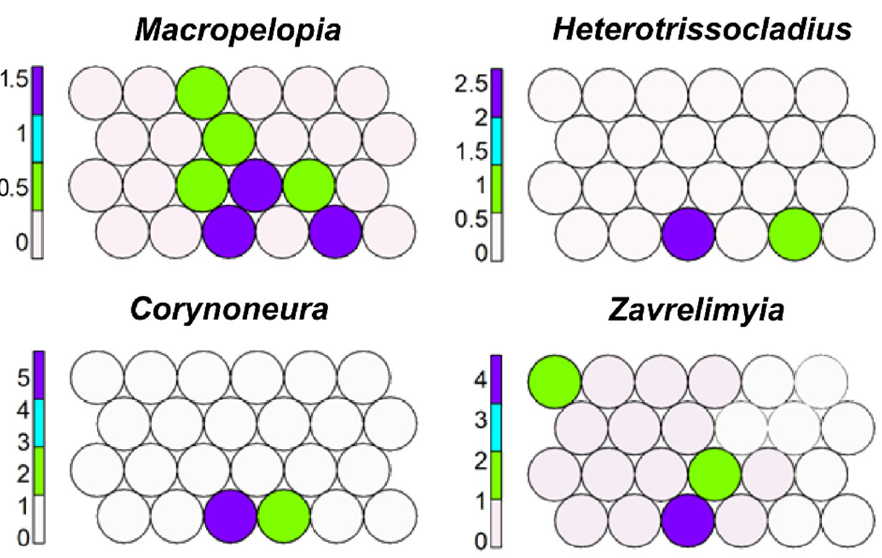
itats (springs, lake profundals), and the morphotype includes different morphotaxa with